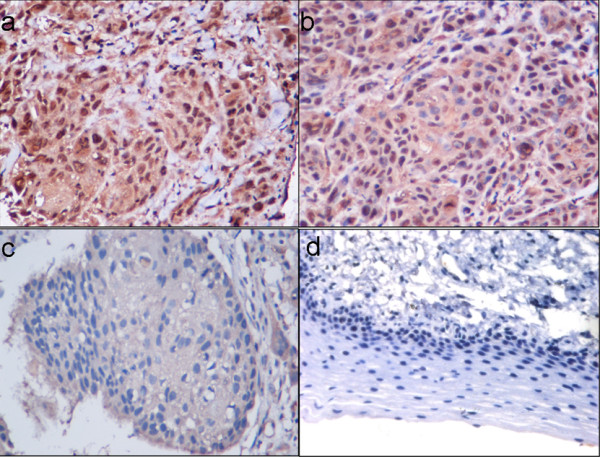
HSP70 expression in LSCC tissues. High HSP70 expression in late stage of LSCC tissues (a-b) was showed comparing to the low HSP70 expression in early stage LSCC(c), (d) is the negative control show the specificity of the antibody. HSP70 shows strong expression (scored as 3+, a), moderate expression (scored as 2+, b), weak expression (scored as 1+, c), and negative expression (scored as 0, d) in cytoplasm(×400).